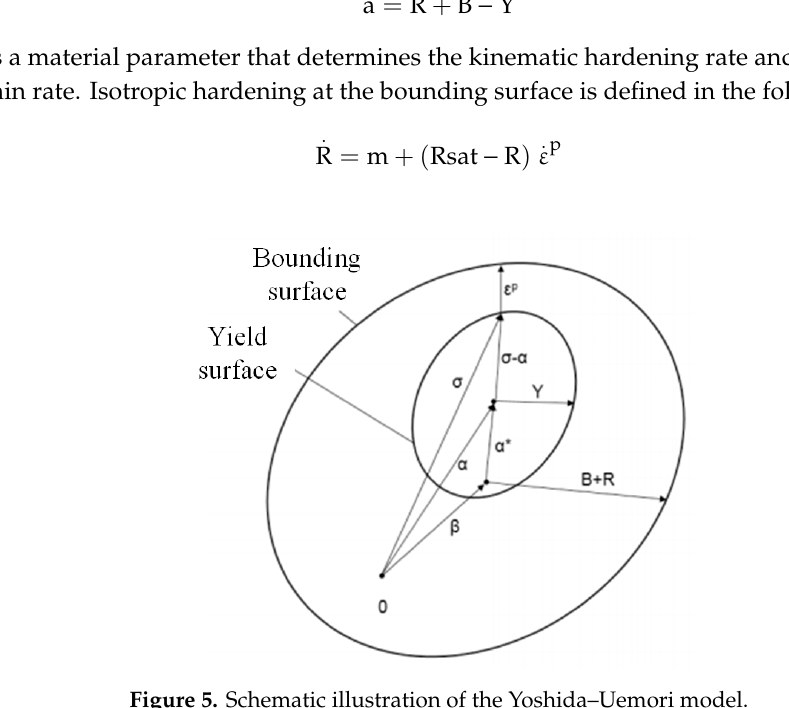
Table 3. Material parameters of the Yoshida-Uemori model for